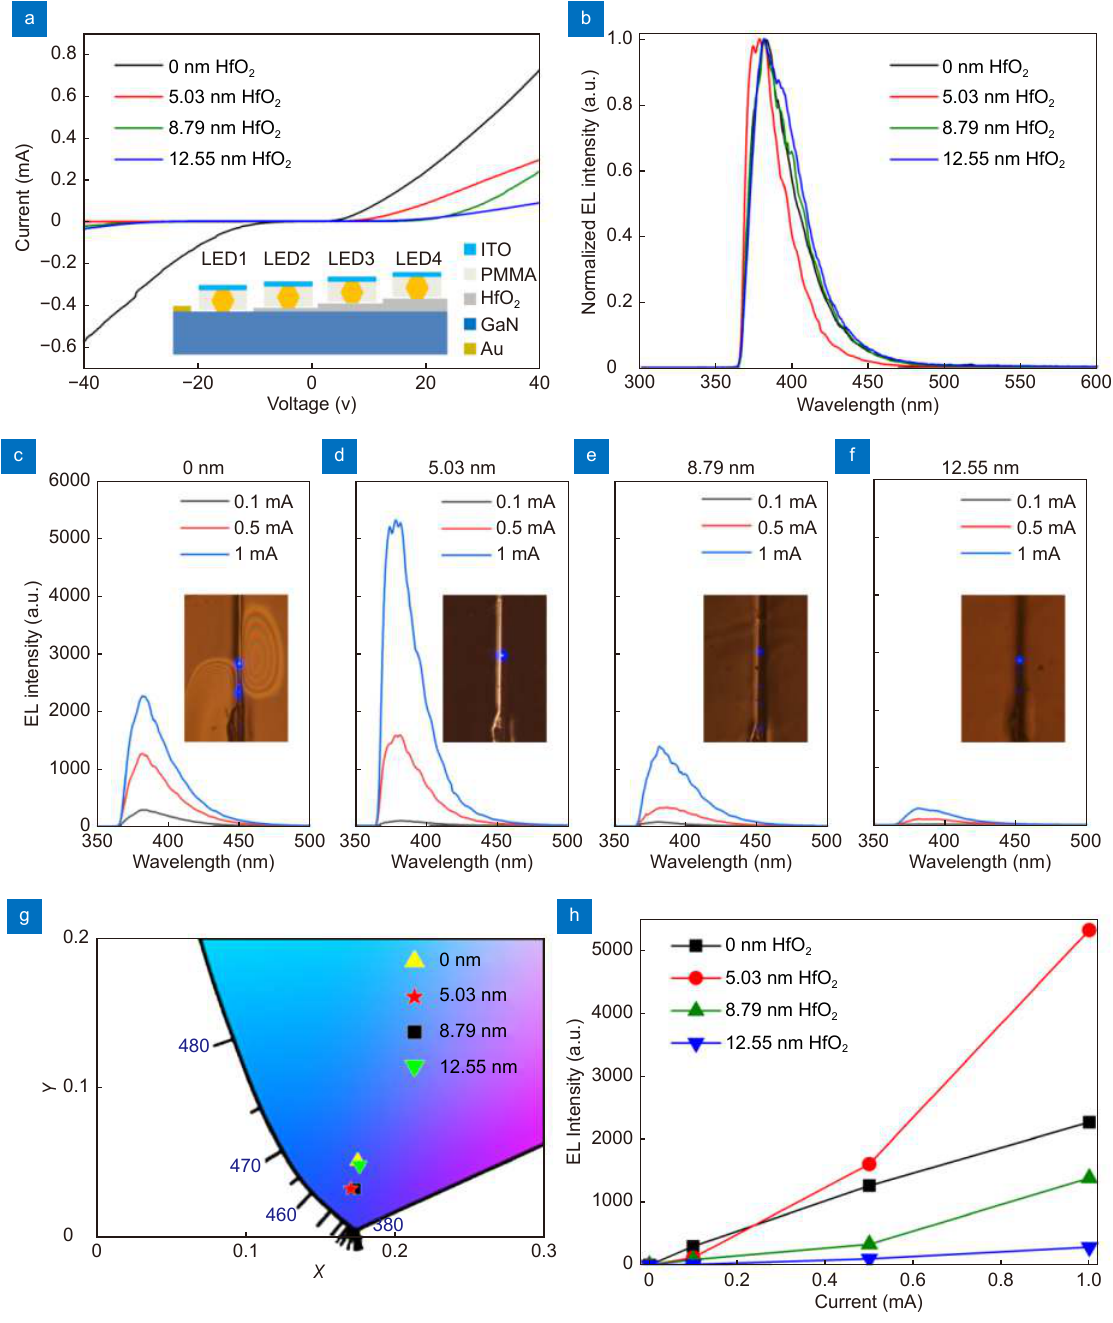
Fig. 5 | ( a ) I-V characteristics of ITO/ZnO/HfO 2 /GaN LEDs. The inset is a schematic diagram for ITO/ZnO/HfO 2 /GaN LEDs. ( b ) Normalized EL spectra for LEDs under an excitation current of 1 mA. ( c−f ) EL intensity of ZnO/HfO 2 /GaN LEDs with HfO 2 films of different thickness and the in- set is the light pictures: (c) 0 nm, (d) 5.03 nm, (e) 8.79 nm, (f) 12.55 nm. ( g ) Chromaticity coordinates of the spectra in (b). ( h ) EL peak intensities of the LEDs from (c) to